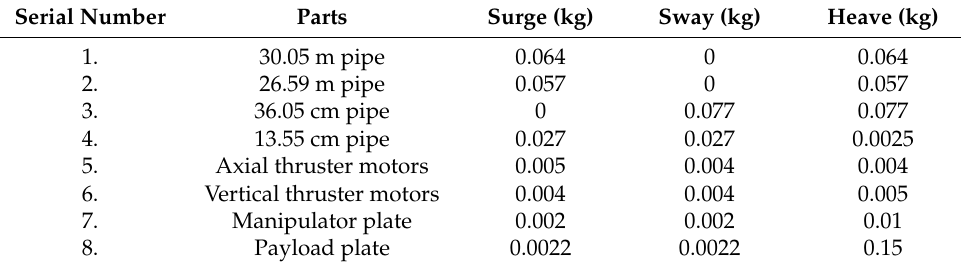
Table 5. Added mass terms calculated for each